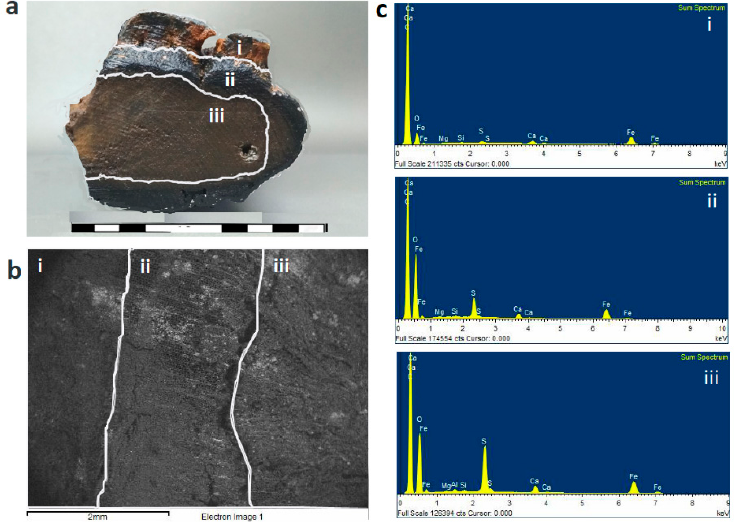
Figure 1. Macroscopic image ( a ) and SEM micrograph ( b ) of a sample where charred (i), semi-charred (ii), and uncharred (iii) material coexisted; ( c ) EDS spectrum of each condition.